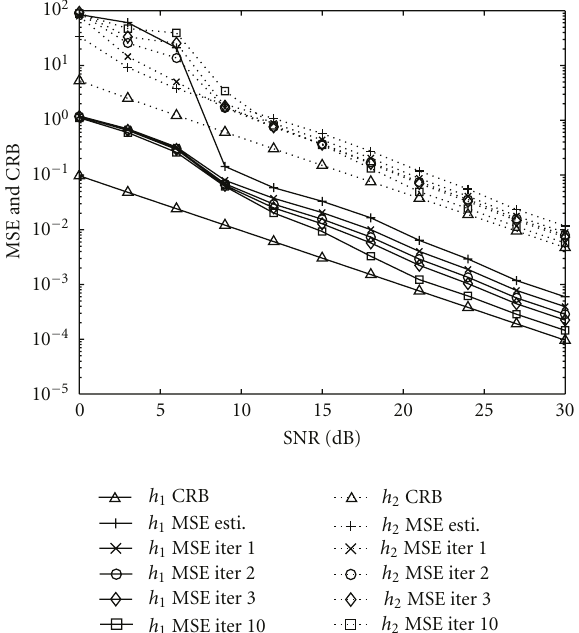
Figure 5: Channel estimation MSE versus SNR: N = 14.